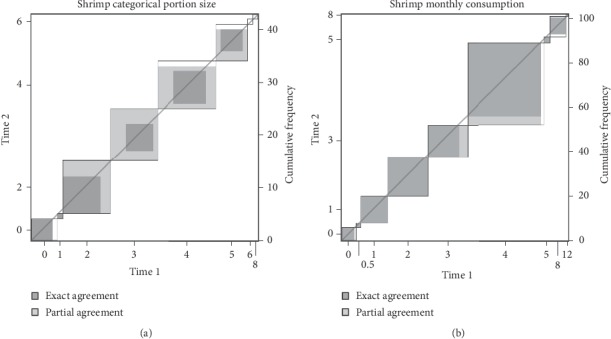
An illustration of the agreement in the responses to the shrimp portion size variable in the noncoastal subgroup (a) and yearly frequency of the consumption of shrimp (monthly) in the coastal subgroup (b). The diagrams represent relatively low level of agreement between the responses.